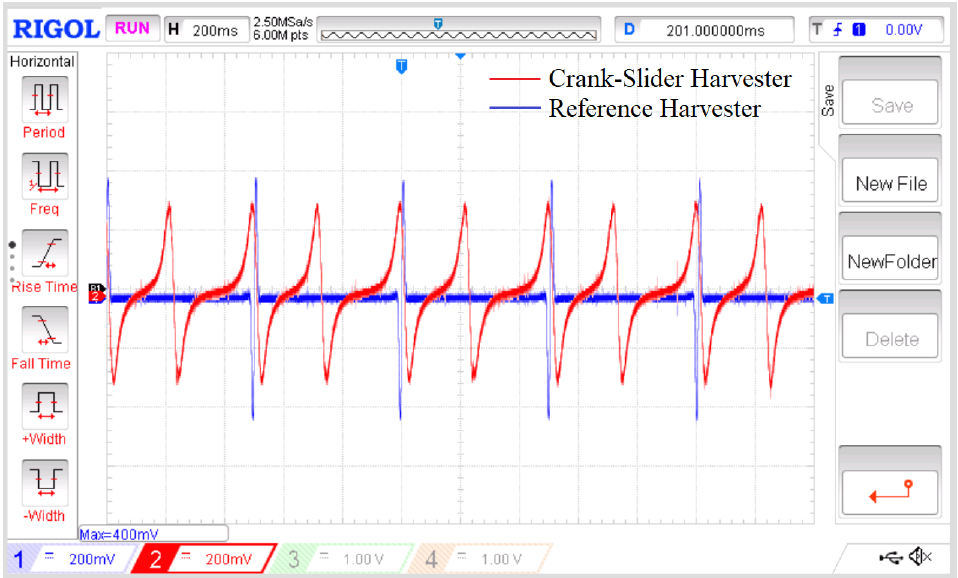
Figure 14. Output at 2 Hz across a 8.4 Ω resistor for the crank-slider harvester vs. the reference harvester, as measured using an RIGOL DS1054 oscilloscope. The crank-slider oscillates across its coil twice for every single pass of the reference harvester. The reference harvester also has a higher peak voltage and a smaller curve